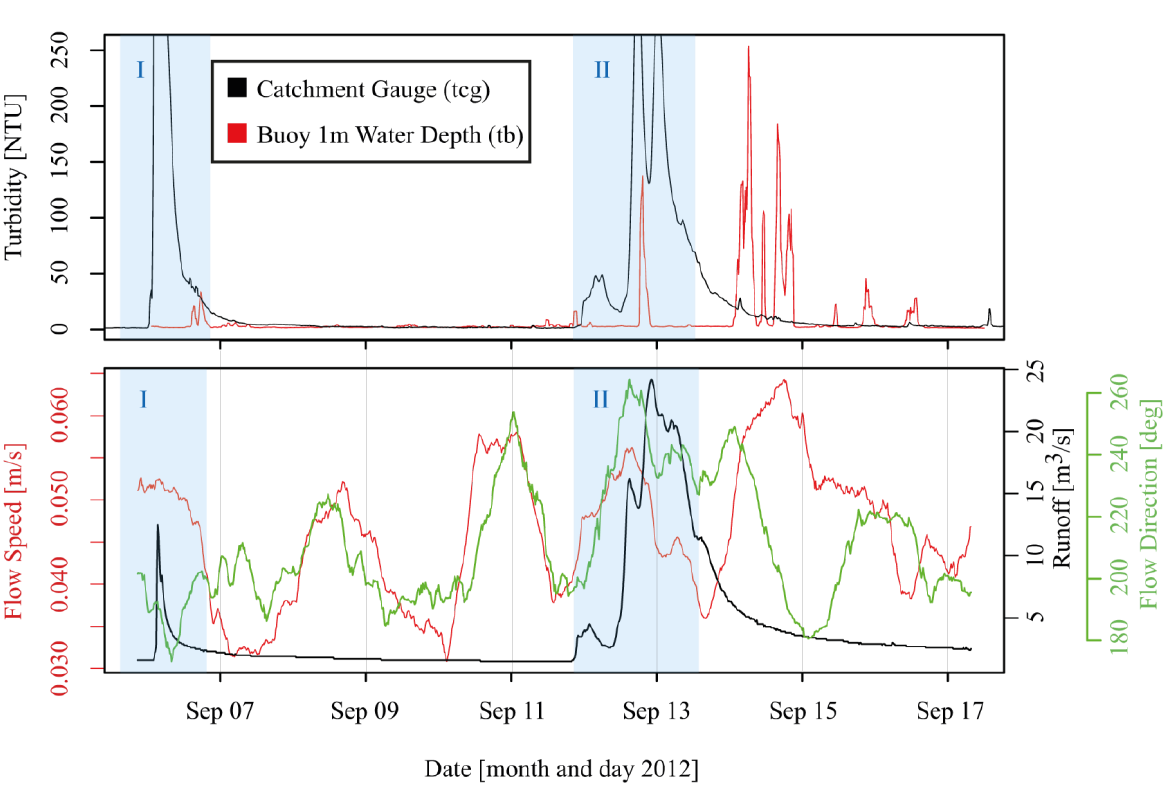
Figure 7. Comparison of turbidity in the Fuschler Ache river at the most downstream gauge (tcg) and of turbidity at the buoy location (tb) at 1 m water depth ( upper graph ). The position of the catchment gauge is represented by label C in Figure 3. River runoff, flow direction and surface flow speed at the buoy location ( lower graph ). I and II represent the two reference runoff events. Graphs shown in the upper plot are scaled with one y-axis. In the lower plot, each graph corresponds to the y-axis of the same